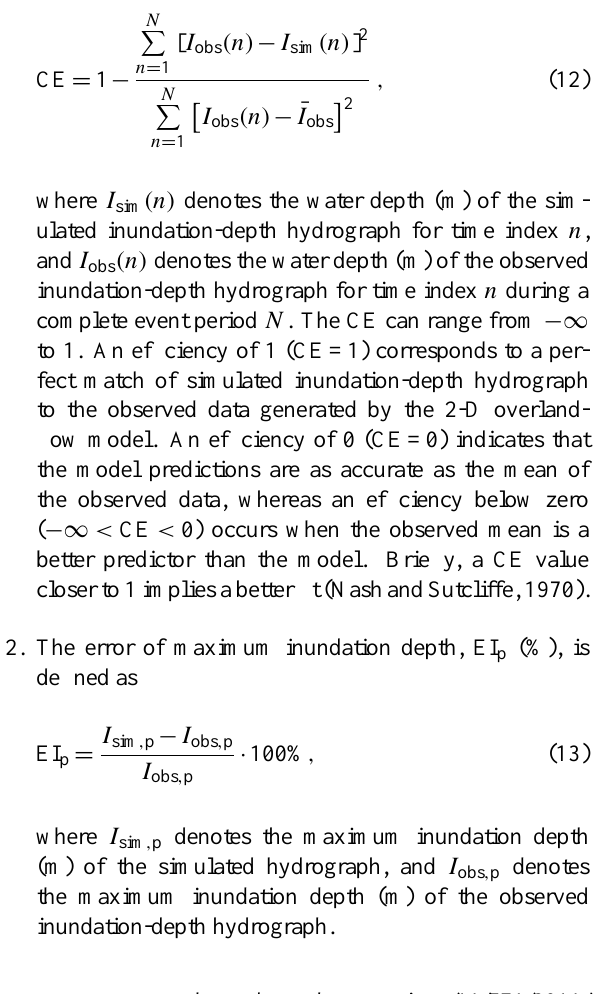
Fig. 5. The 24-h design hyetograph pattern for all rain gauges in Yunlin (Cheng et al., 2001).